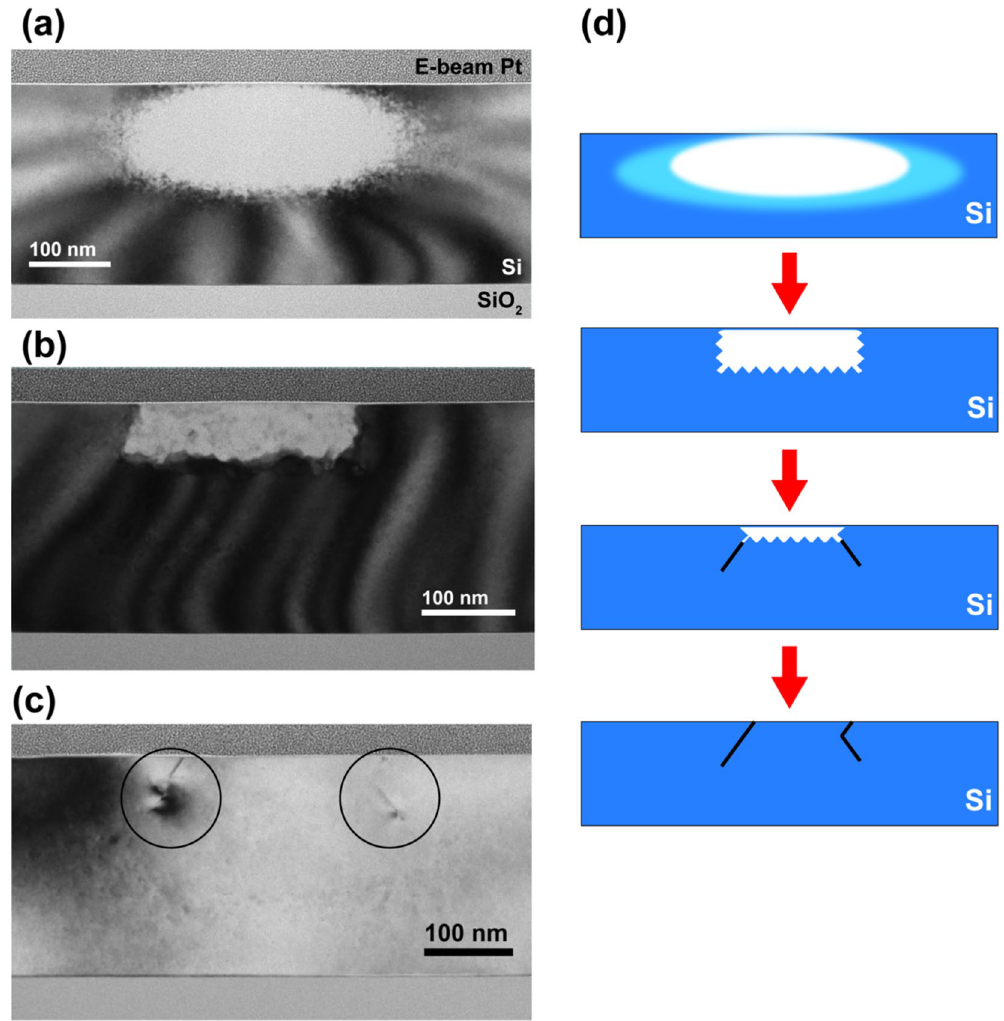
Figure 3. Bright field transmission electron microscopy (TEM) images obtained along the [011] axis from samples in which Si 2 + was implanted in a pattern of lines along [011], each made up of 50 nm steps with ~1 × 10 5 ions implanted per step. The dose is thus 2 × 10 3 ions per nm. Cross sections were cut after ( a ) implantation, and after annealing at ( b ) 500 °C and ( c ) at 600 °C for 30 minutes. As-implanted ( a ), the amorphized area is ~370 nm wide and 140 nm deep. After ( b ) annealing at 500 °C, the amorphous area reduces to ~245 nm wide and 63 nm deep. After ( c ) annealing at 600 °C, recrystallization occurs but leaves a pair of residual defects, highlighted with black circles. The defect on the left makes an angle of ~55° with the surface, whereas the defect on the right has a kink with an angle of ~100°, consistent with the angle between {111} facets. In ( c ), the surface pit expected for these implant/anneal conditions would be too shallow to be visible. ( d ) A schematic of recrystallization via multi-directional solid phase epitaxial regrowth where the growth fronts form {111} nanofacets. Fully amorphous areas are shown in white and crystalline Si in blue. The transition area in the first panel indicates a partially amorphized